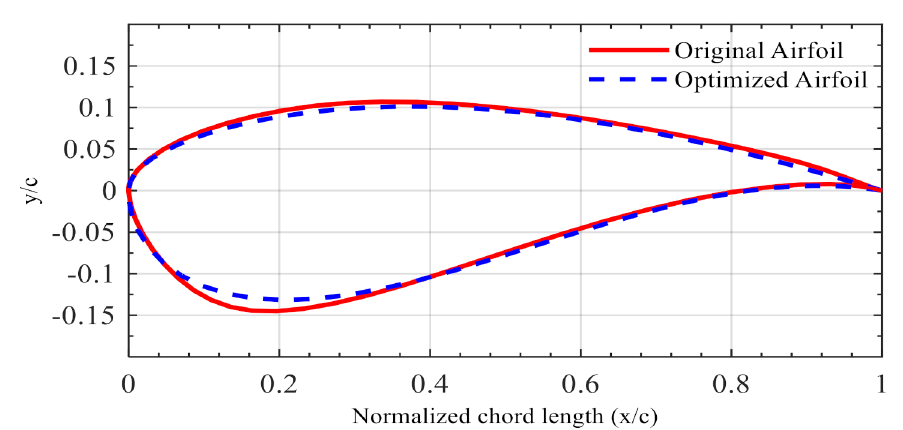
Figure 9. Comparison of original and optimized airfoil shape (NREL S-821).